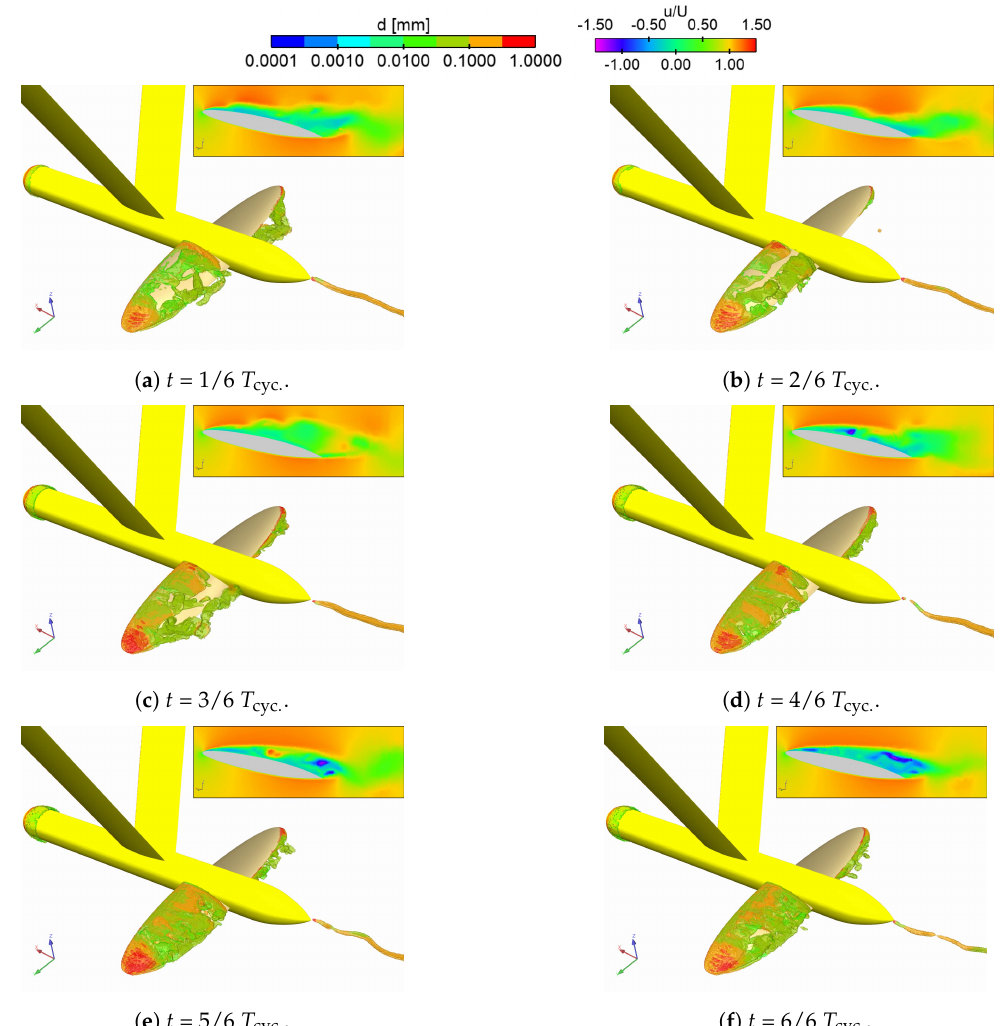
Figure 19. Visualisation of a cavitation shedding cycle from EE simulations. The time interval between two consecutive images is equal to 5.7 ms. Cavity volume by α g ∈ [ 0.1,0.9 ] is coloured according to the predicted diameter of the vapour phase. The insert frame shows u m / U ∞ on the y -plane at midspan. Animation file corresponding to the snapshots is provided as Supplementary Material (Video S2) to this paper.